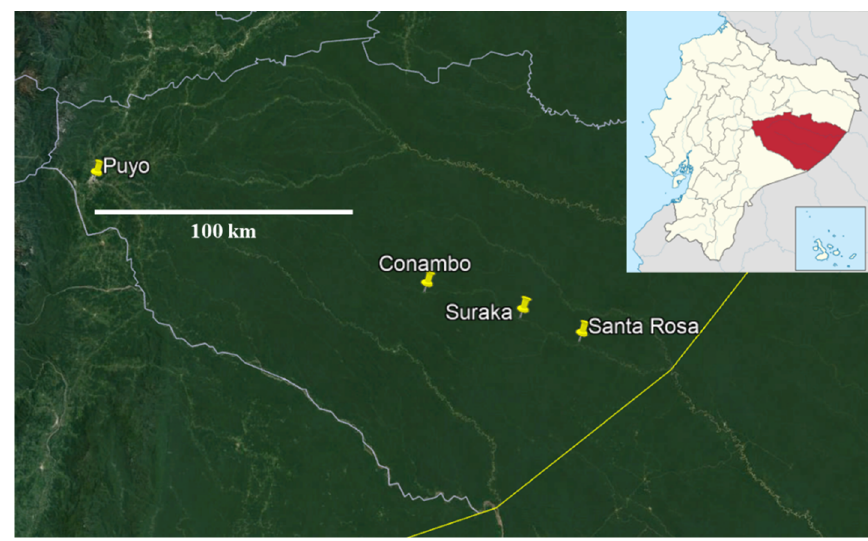
Figure 3. Map of the Pastaza